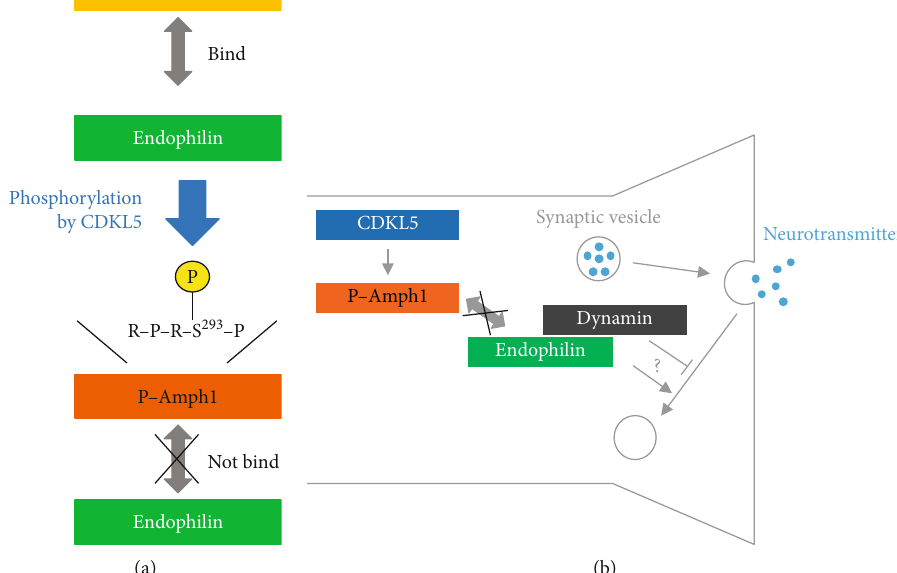
Figure 2: Phosphorylation of Amph1 by CDKL5 and its biological importance at the synapse. (a) Amph1 binds to endophilin, an endocytosis-related protein. Phosphorylation of a Ser-293 residue in the RPRSP sequence of Amph1 results in the loss of this binding ability in vitro . (b) The predicted biological importance of Amph1 phosphorylation at the synapse. At the presynaptic membrane, synaptic vesicles release neurotransmitters into the synaptic cleft and are recycled by endocytosis. A complex centred around dynamin is believed to facilitate invagination and separation of the membrane during vesicle recycling. Because Amph1 and endophilin are included in this complex, CDKL5-mediated phosphorylation of Amph1 is predicted to either positively or negatively a ff ect membrane